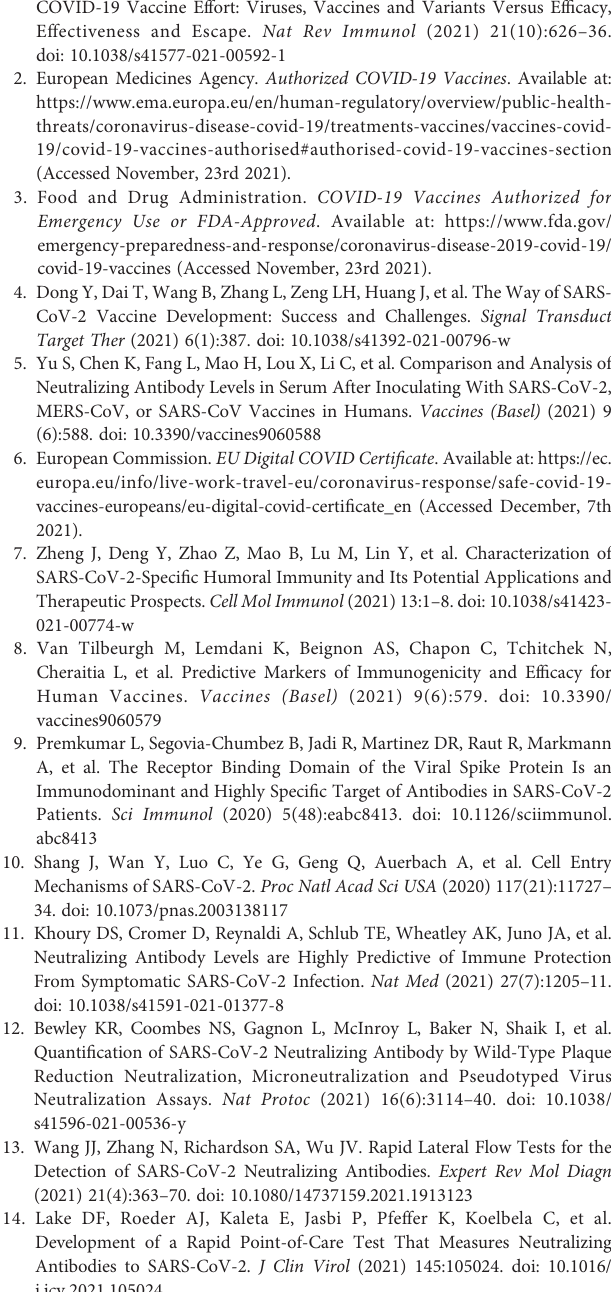
and by IgG/Neutralizing Antibody Rapid Test in 70 sera from differently vaccinated individuals. According to manufacturer ’ s instructions, samples were considered positive for neutralizing antibodies when ≥ 30% inhibition (see red line) was measured. Supplementary Figure 5 | Assessment of neutralizing antibodies with rapid test cassettes in 180 participants to the study.